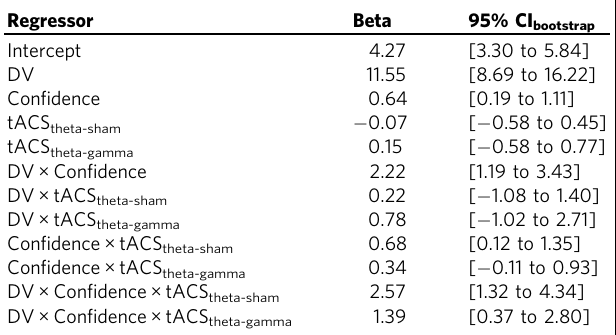
Table 1 Results of MGLM explaining choices (1 = LL reward, 0 = SS reward) in the con fi dence accuracy